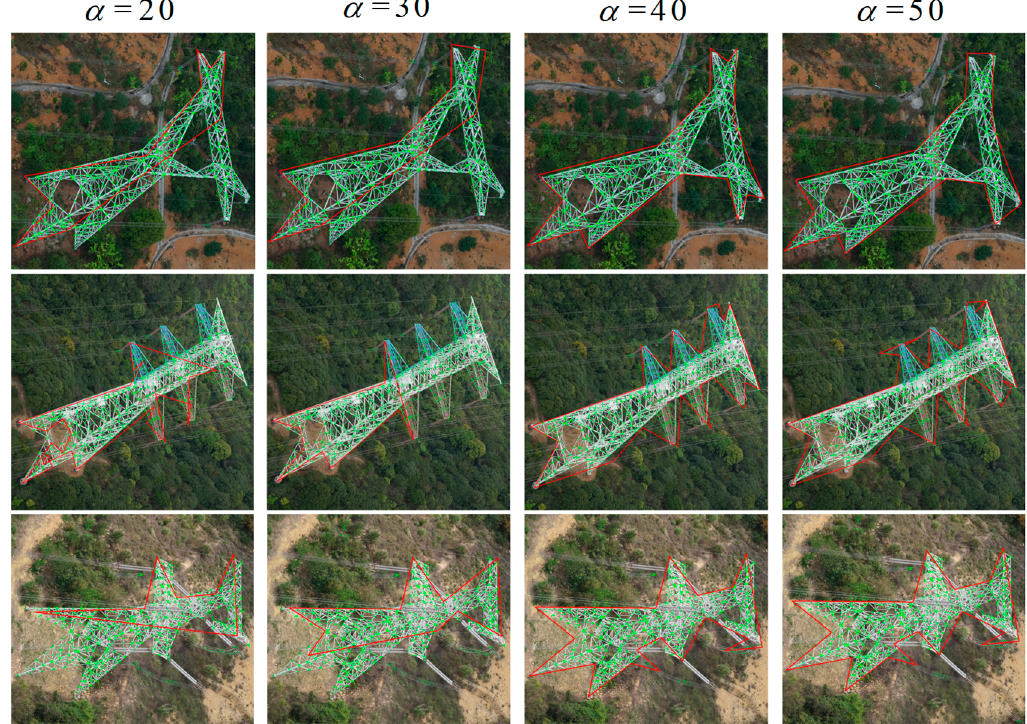
Figure 13. The results of alpha shape method with di ff erent α values. The red line segments in images are the outer contours extracted by alpha shape method. The green points are the clustered intersection points of extracted line segments in images.